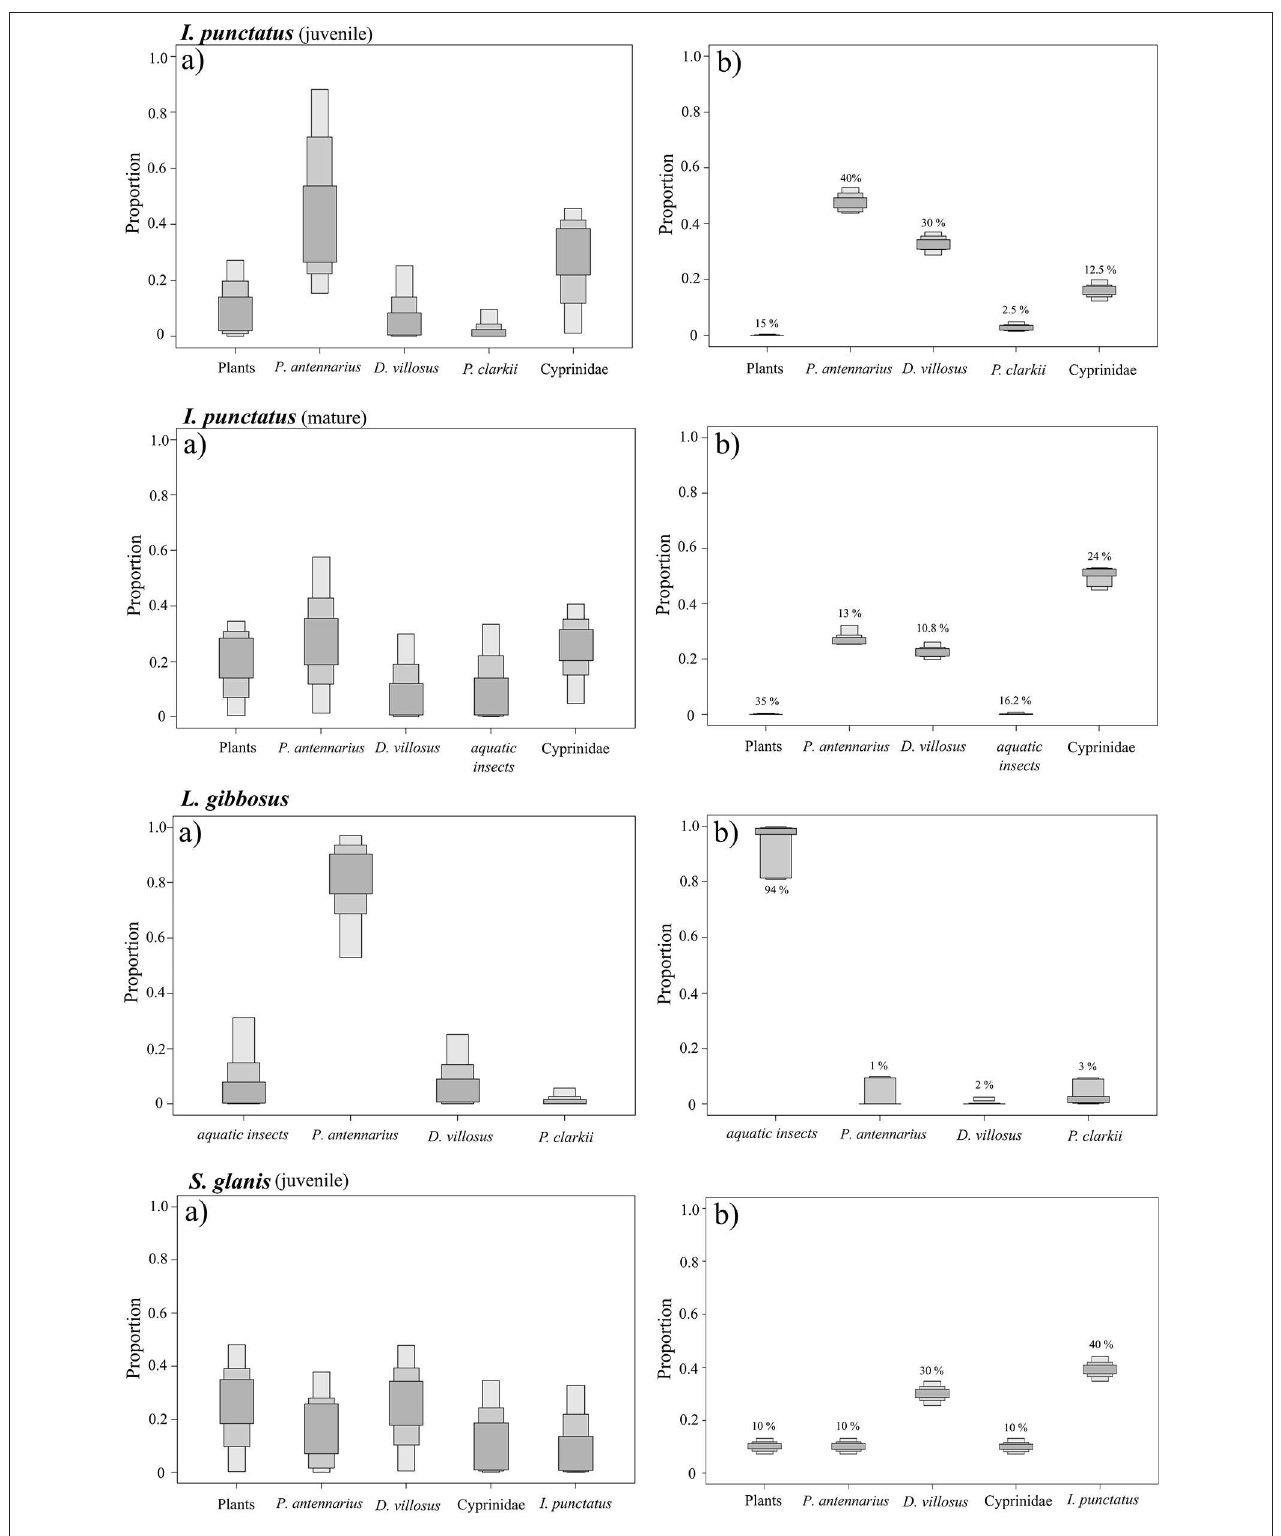
FIGURE 3 | Estimated contribution of consumed prey items to the diet of: Ictalurus punctatus (juveniles), Ictalurus punctatus (matures), Lepomis gibbosus and juvenile Silurus glanis using dietary priors. (a) Based on the 5* most consumed prey items; (b) including the number of occurrences (N%) of the 5* most consumed prey items (indicated in %). *: 4 in the case of L. gibbosus . The prior based analysis was performed using the R-package “SIAR” with credibility intervals of 95%.